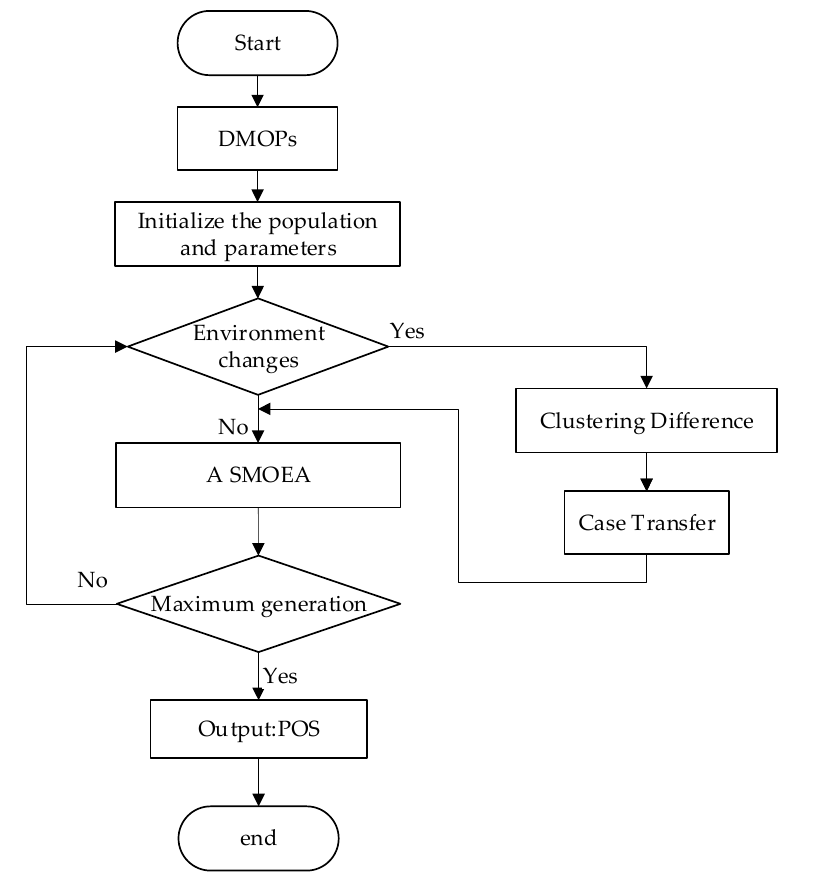
Figure 2. Procedure of TCD-DMOEA.